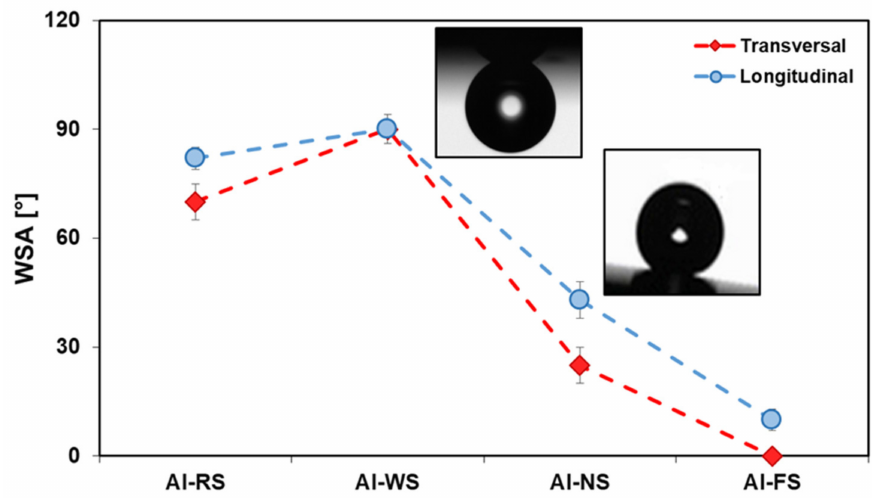
Figure 7. Bidirectional water sliding angles of the as-received aluminum and rough aluminum samples after silanization along the longitudinal and transverse direction to the lamination